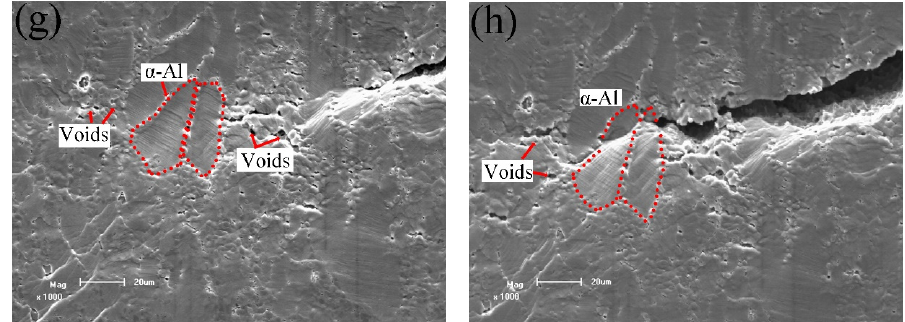
Figure 10. In-situ SEM images of the T6-treated alloys at stress / load level of: ( a ) 0 MPa / 0 N, ( b ) 223 MPa / 635 N, ( c ) 234 MPa / 655 N, ( d ) 230 MPa / 644 N, ( e ) 163 MPa / 580 N, ( f ) 139 MPa / 410 N, ( g ) 111 MPa / 340 N, ( h ) 97.42 MPa / 310 N.